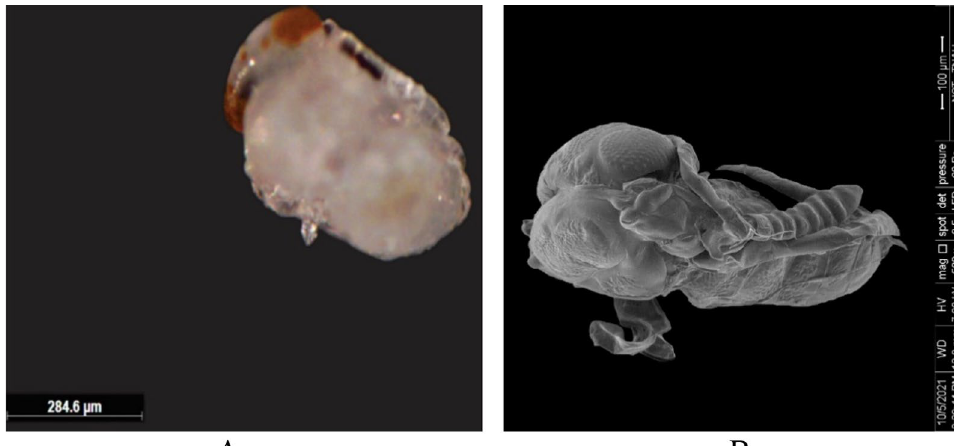
Fig. 8 A, B Second pupal phase of T. remus